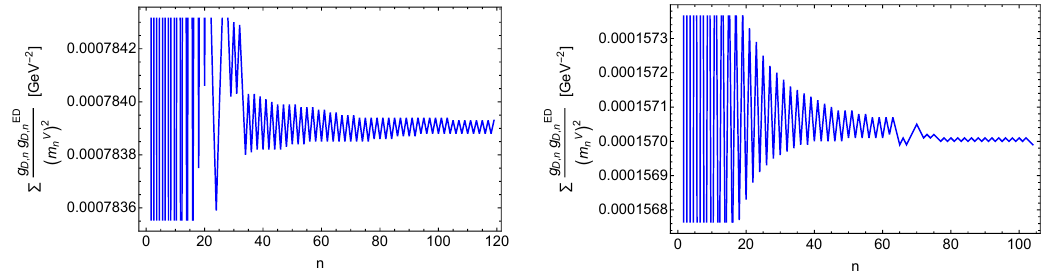
Figure 5 . Left (right): gauge (Higgs) couplings as a function of x V other parameters are the same as (cid:12)gure 2, for BM I.